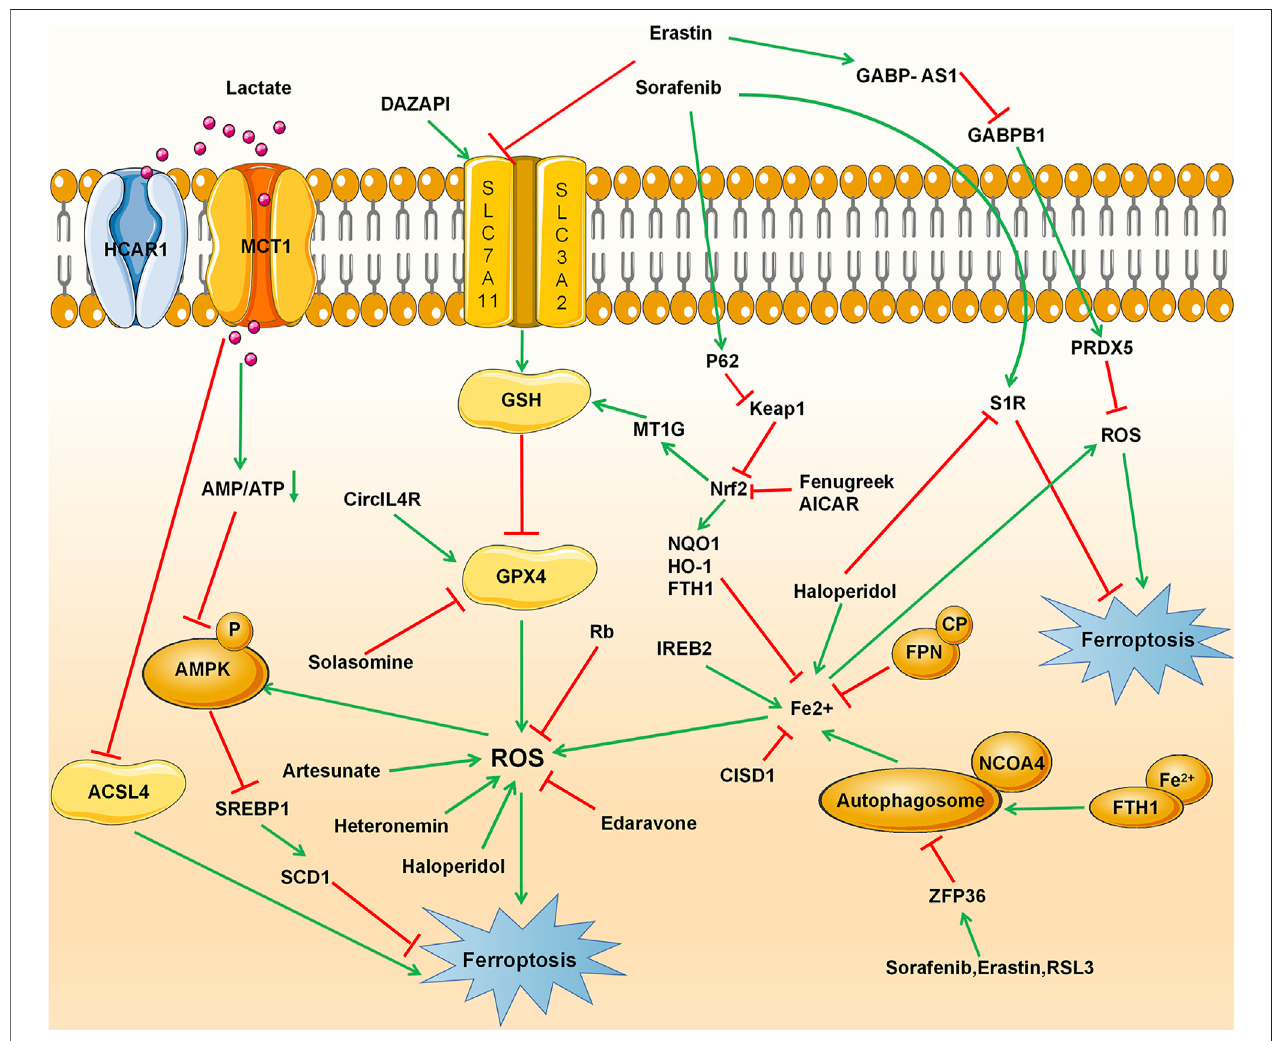
FIGURE 2 | Ferroptosis signaling pathway in hepatocellular carcinoma (HCC), including conventional drivers and suppressors, non-coding RNAs, RNA-binding proteins, ACSL4, and metallothionein.